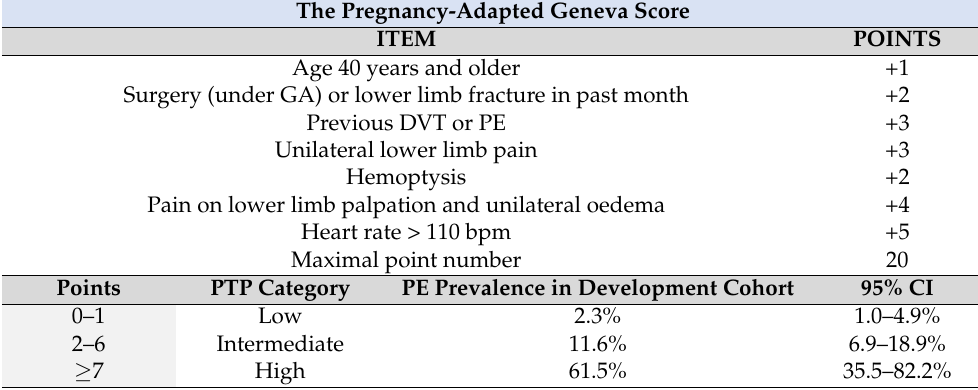
Table 1. The Pregnancy-Adapted Geneva score for assessment of pre-test clinical probability of PE in pregnant women [21]. The Pregnancy-Adapted Geneva Score ITEM POINTS Age 40 years and older +1 Surgery (under GA) or lower limb fracture in past month +2 Previous DVT or PE +3 Unilateral lower limb pain +3